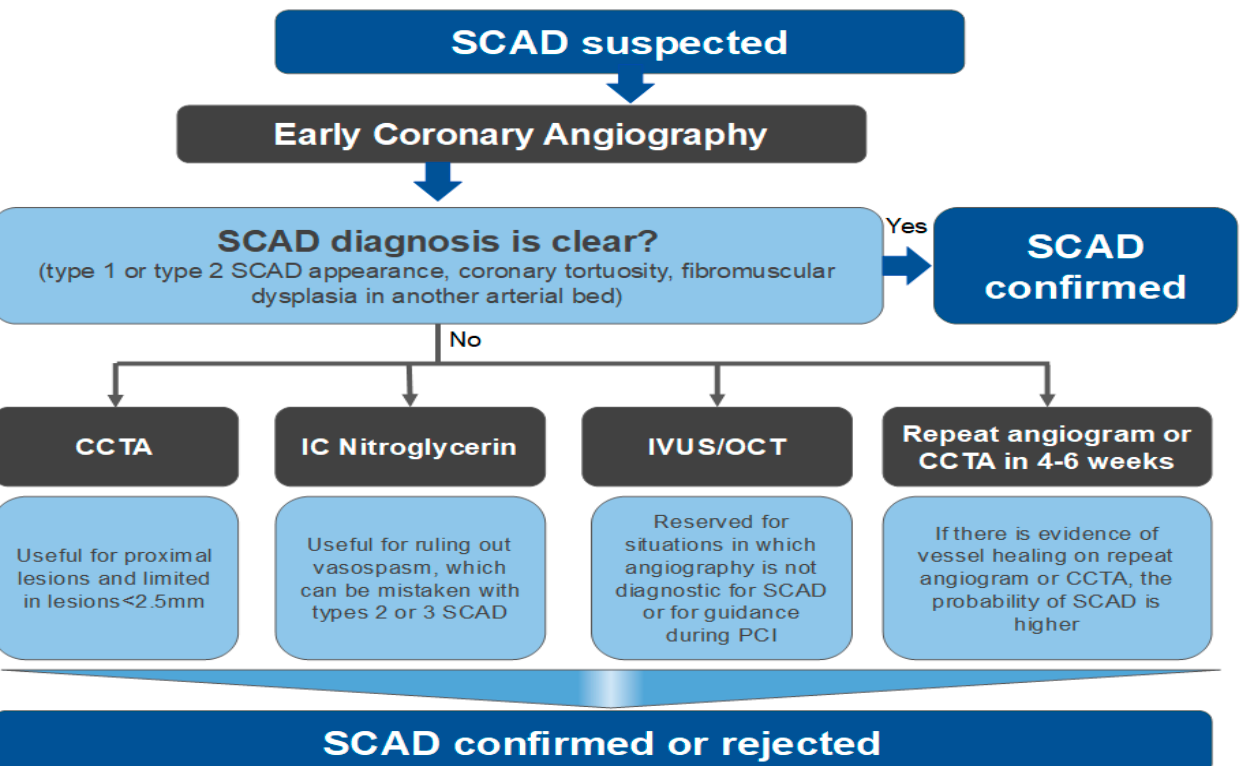
Figure 3. Flowchart for the diagnosis of spontaneous coronary artery dissection (SCAD). CCTA: Coronary Computed Tomography Angiography; IVUS: Intravascular ultrasound; OCT: Optical coherence tomography; IC: intracoronary; PCI: percutaneous coronary intervention.